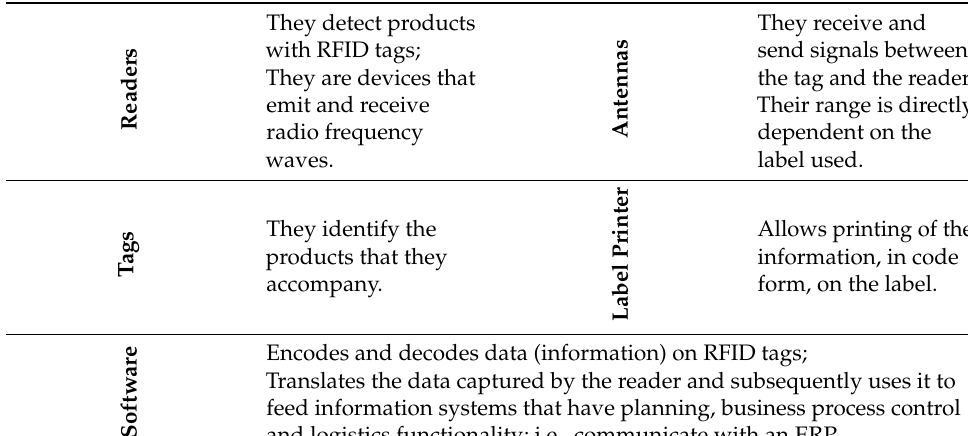
Table 2. RFID components (adapted from [7]).